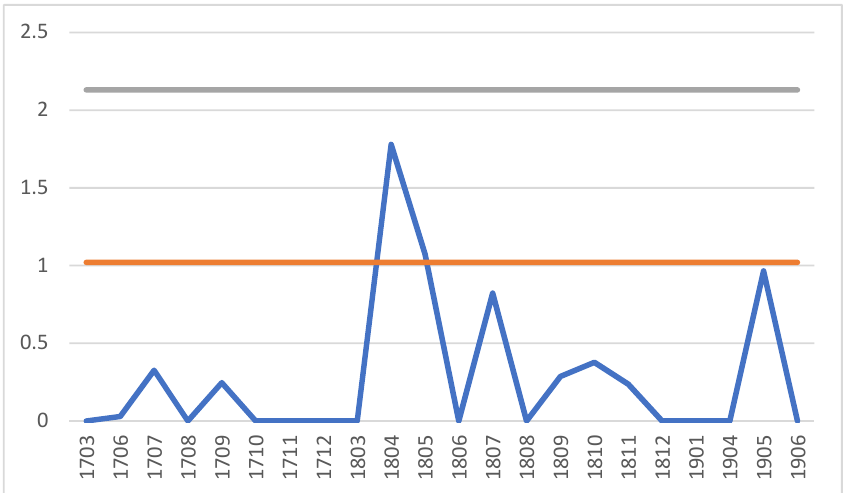
Figure 8. Keyword frequency of the antecedent “service provider”. Figure 9 represents the keyword frequency of the antecedent “Obike”. The gray line represents the upper cut-off value, and the orange line represents the lower cut-off value. It indicates that the